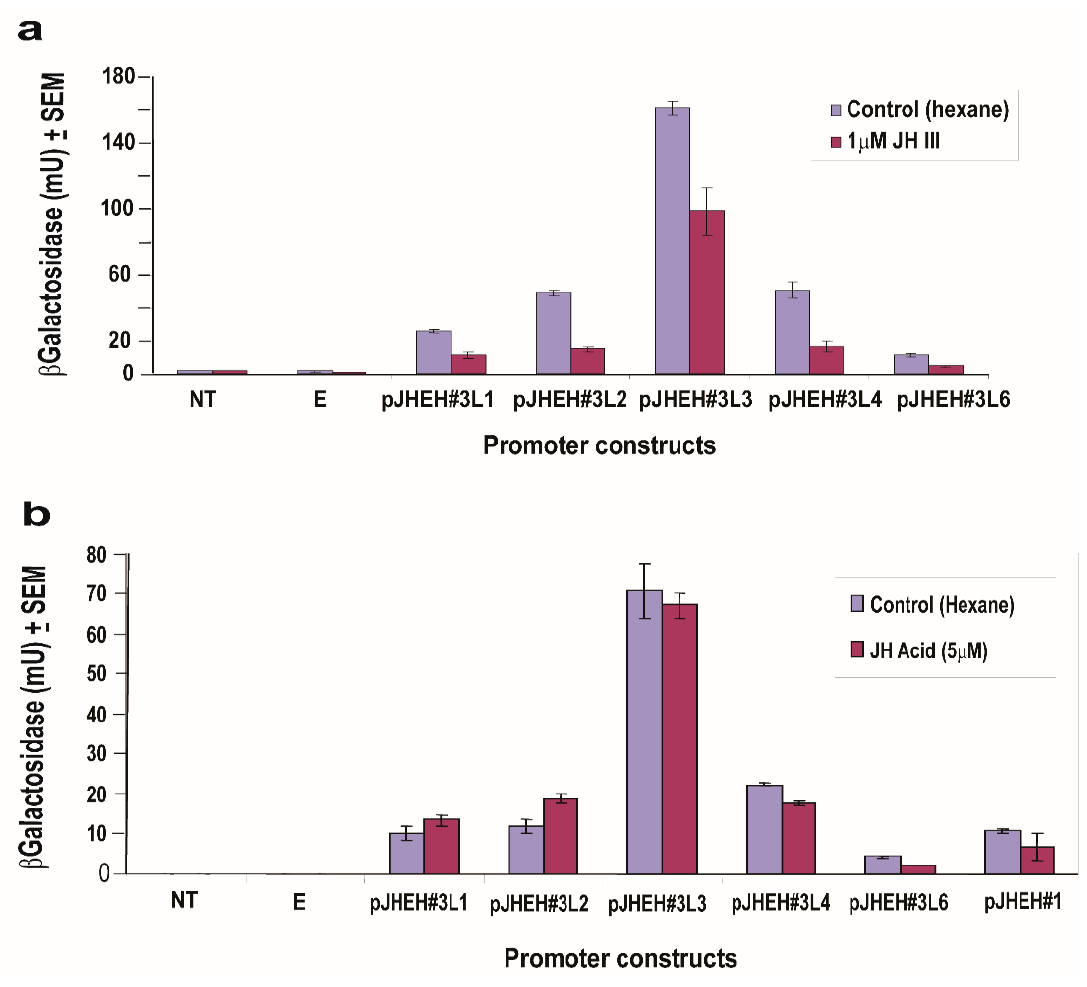
Figure 10. Transcriptional activities of different jheh 3 promoter sequences in transfected D.Mel2 cells in the presence of JH III (1 µ M) ( a ) and in the presence of JH IIIA (5 µ M) ( b ). The different promoter sequence lengths are found Figures 6 and 8. Non-transfected cells (NT) and cells transfected with empty plasm © (E).